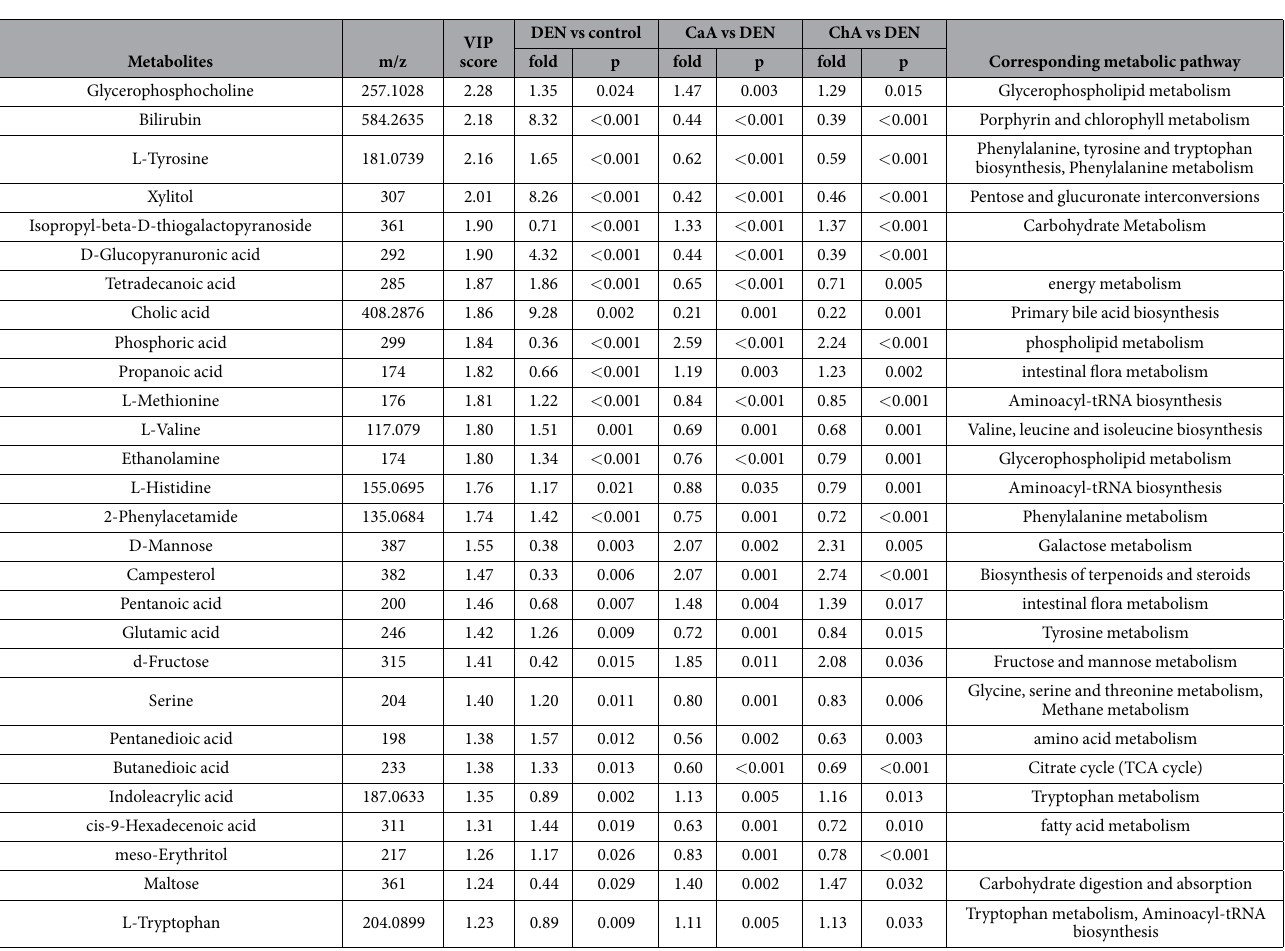
Table 1. List of candidate biomarkers for HCC and evaluating the effects of CaA and ChA.